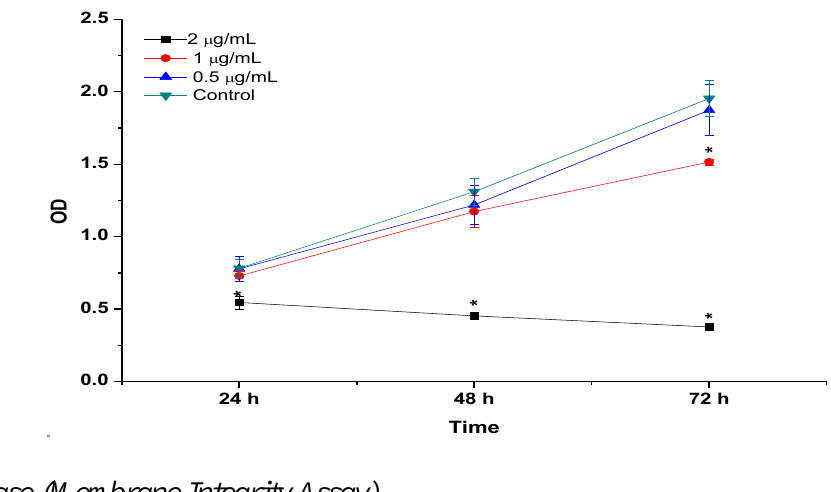
Figure 7. BrdU Cell proliferation assays, MG 63cells was treated with CaCO 48 and 72 h incubation